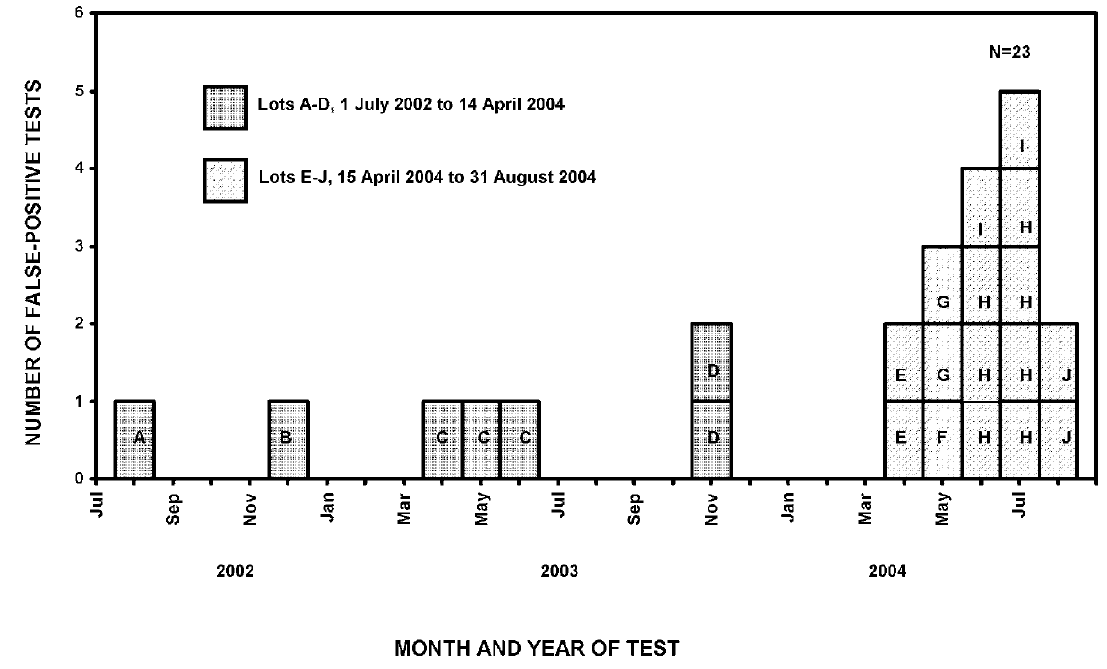
Figure 1. Epidemic curve of false-positive OraQuick rapid HIV antibody test results, oral fluid, by Month and Lot, University of Minnesota study, July 2002 through August 2004.